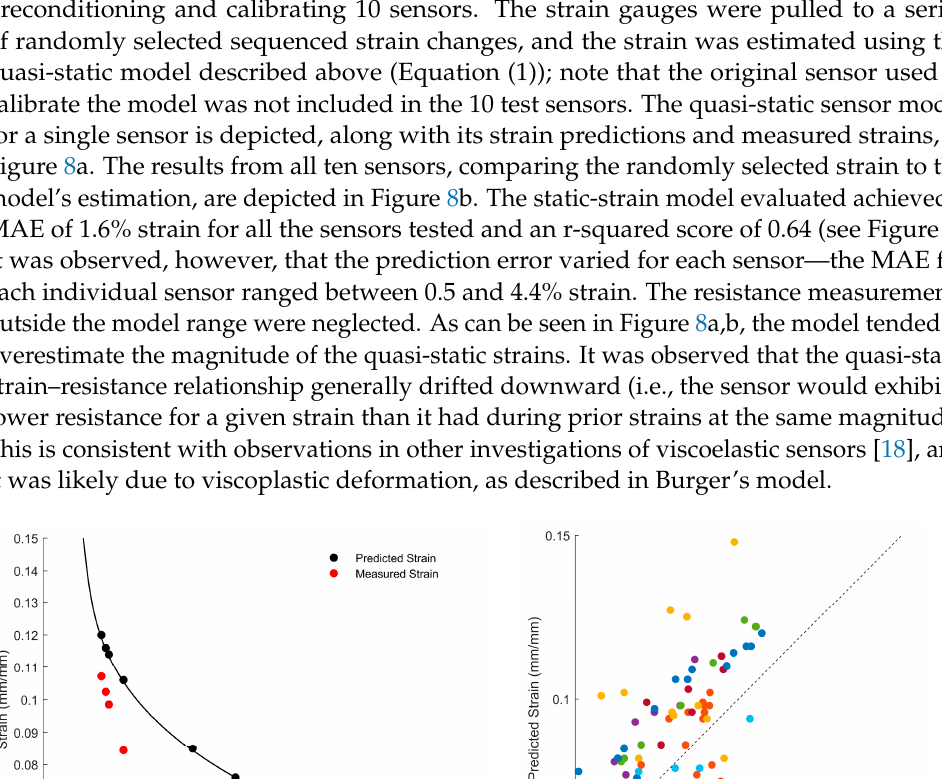
Figure 9. The predicted resistance value (dotted blue line) compared to the true sensor resistance (black line) during the validation test. The top plot is for validation conducted at a rate of 0.05 mm/s, the middle plot is the validation test conducted at a rate of 0.50 mm/s, and the bottom plot is the validation test conducted at a rate of 5.0 mm/s.